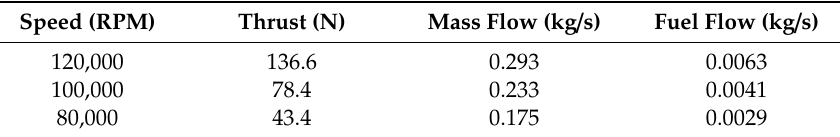
Table 3. Summarized experimental data for BMT 120 KS, taken from